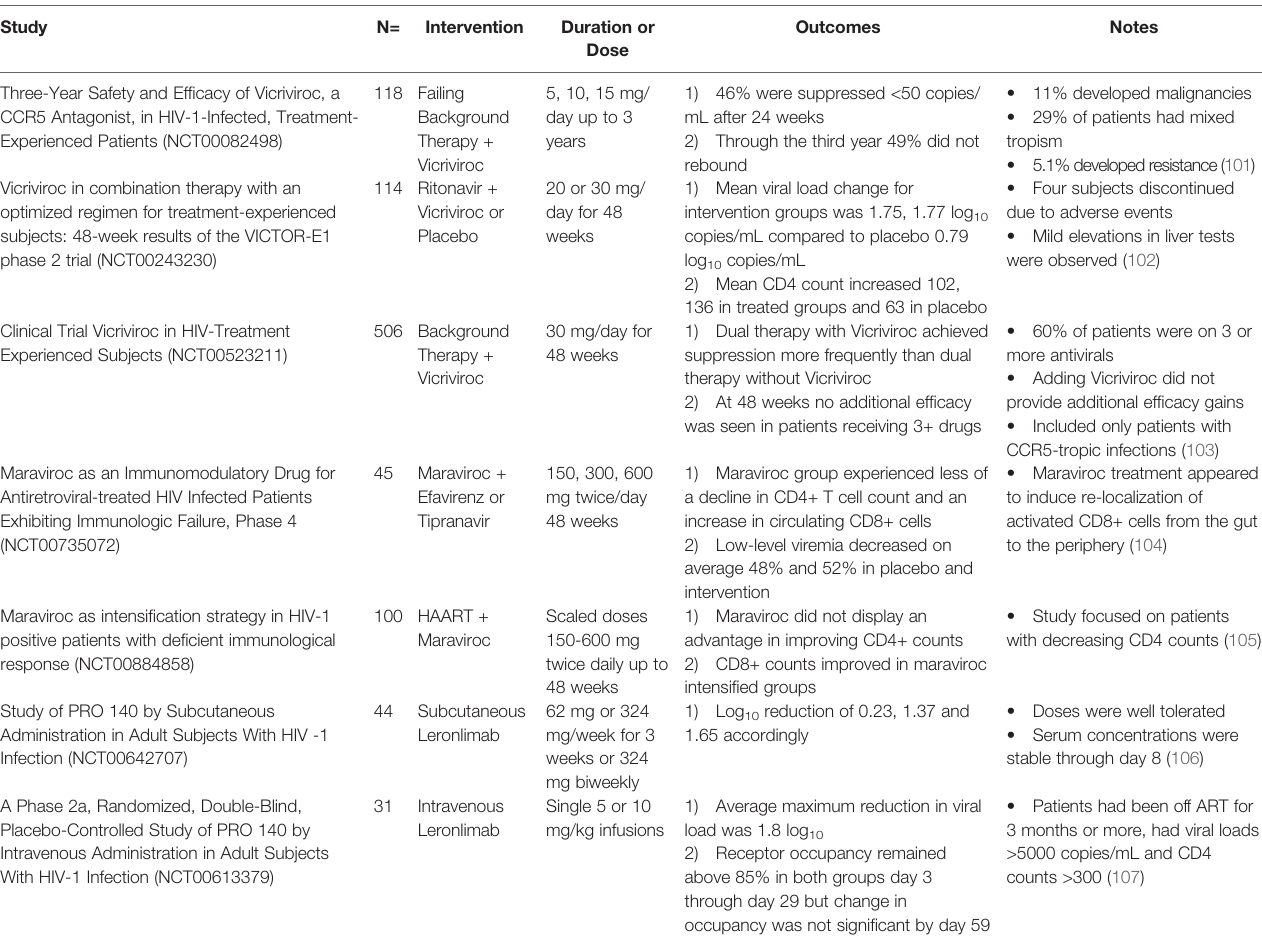
TABLE 1 | Overview of clinical trial outcomes of selected CCR5 antagonists in HIV-1